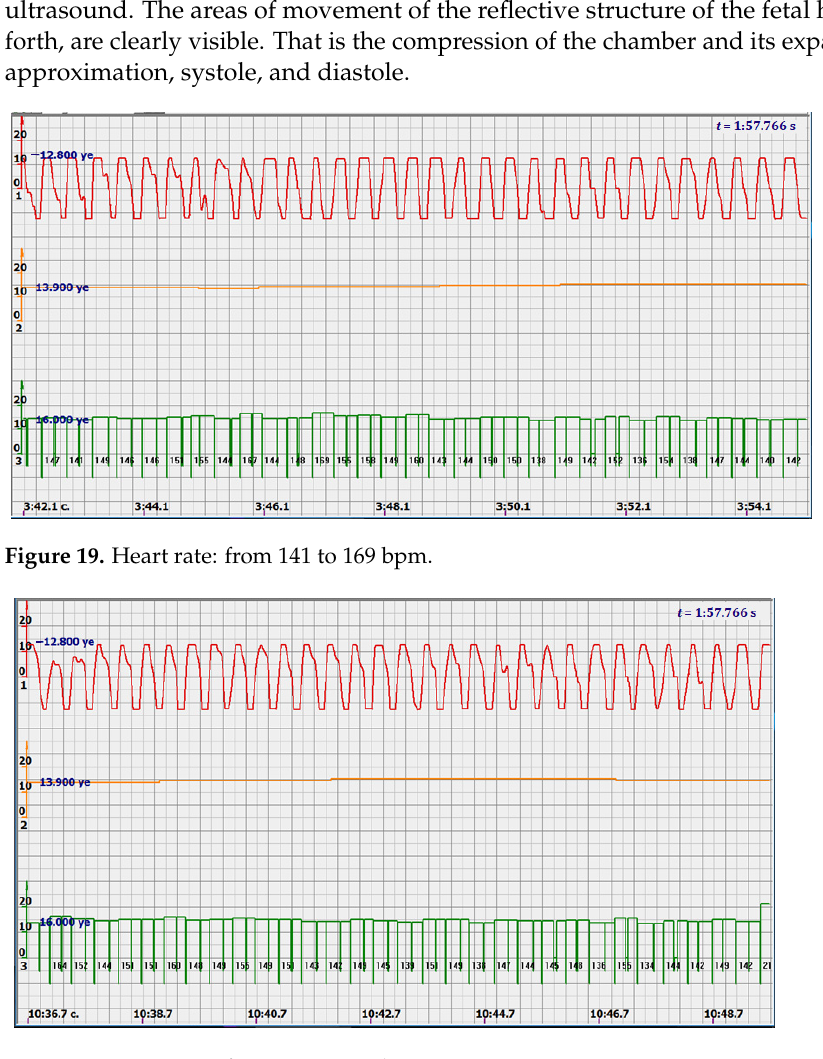
Figure 20. Heart rate: from 140 to 155 bpm.